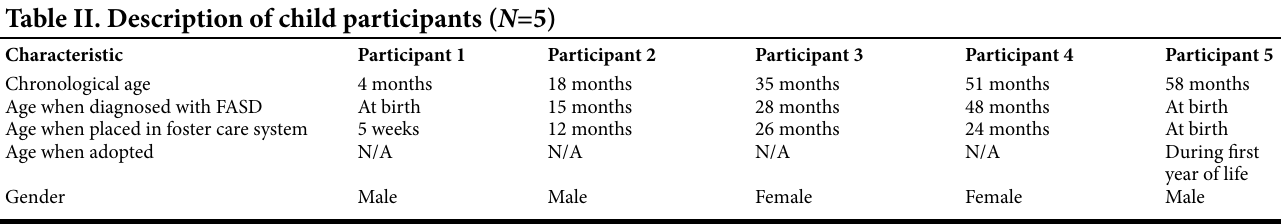
Table II. Description of child participants ( N